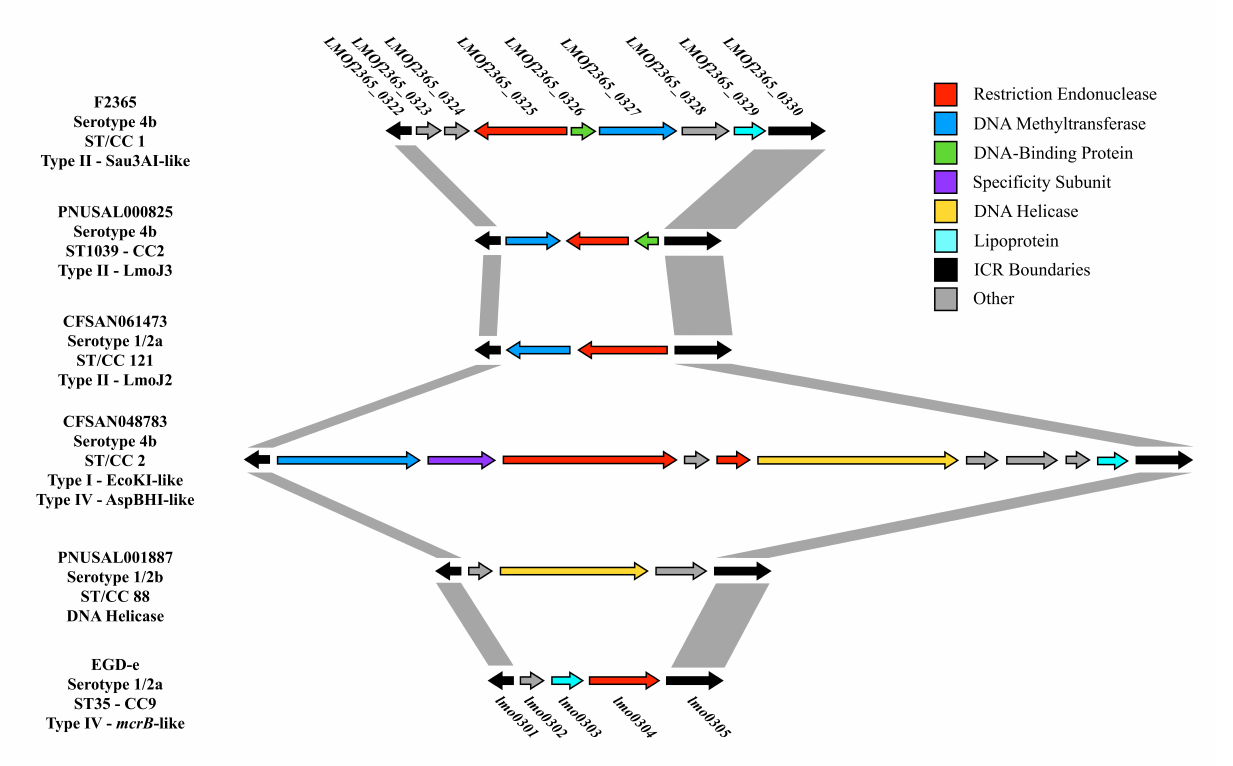
Figure 1. Genetic organization of the immigration control region (ICR) in six Listeria monocytogenes strains. Conserved boundaries of the ICR are indicated with black arrows and with gray connections. Arrows are color-coded based on gene annotations, which are provided in the key. Genomes were selected in order to visualize the most abundant and diverse content found in the ICR. Gene names above F2365 (e.g., LMOf2365_0322 ) and EGD-e (e.g., lmo0301 ) denote RefSeq locus tags for these reference L. monocytogenes